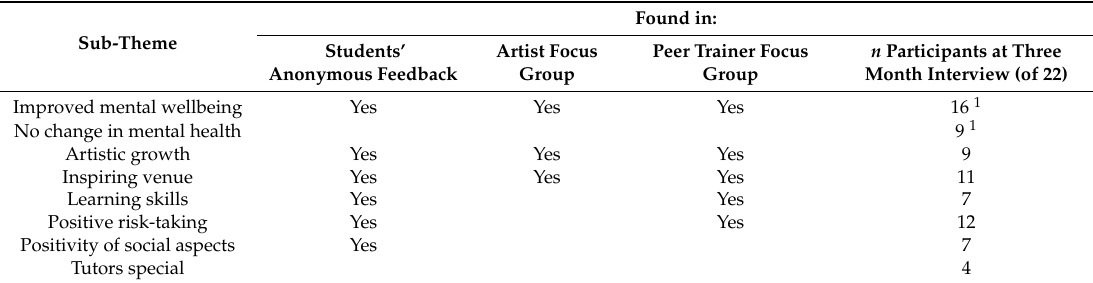
Table 4. The theme Transforming students’ lives and its